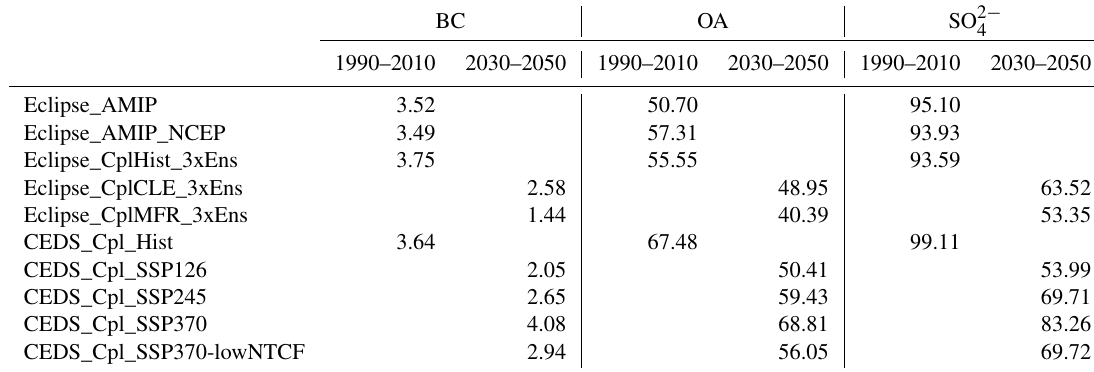
Table 5. Arctic BC, OA, and SO 2 − burdens in 1990–2010 and 2030–2050 periods as calculated by the 4